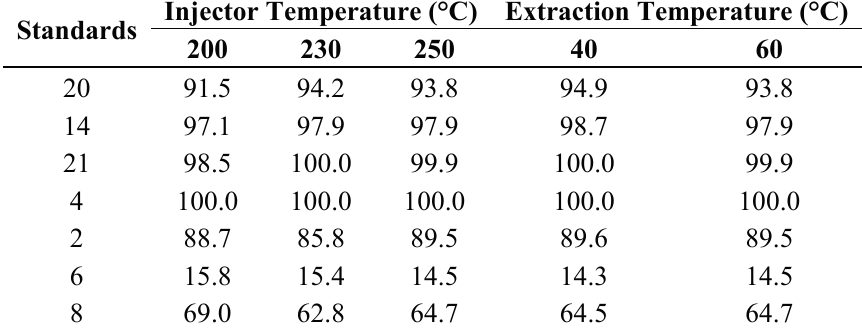
Table 3. Average variation (peak area ratio) of seven monoterpene standards based on injection and extraction